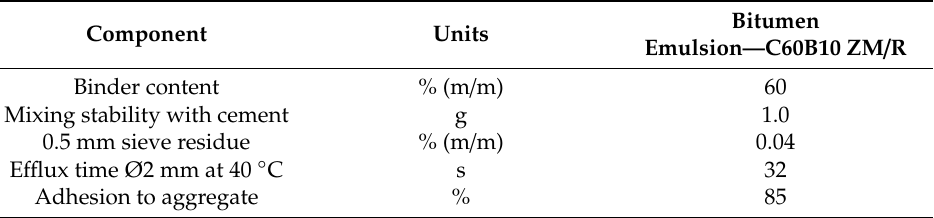
Table 2. Physical properties of asphalt